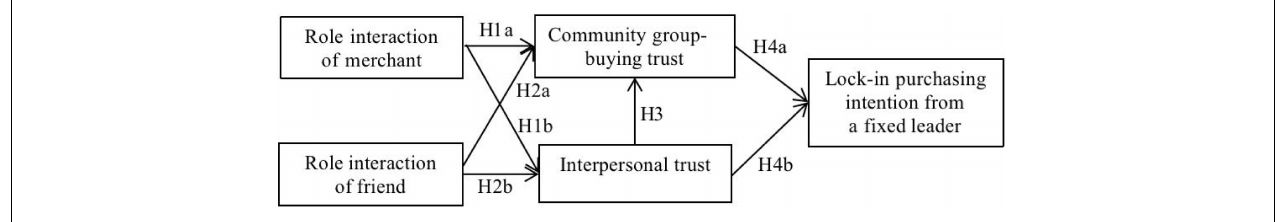
FIGURE 1 | Conceptual model of the